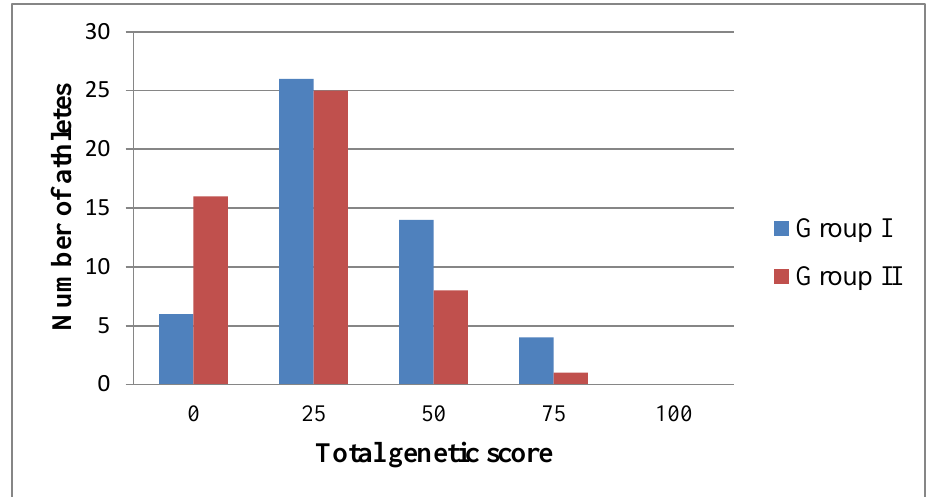
Figure 2. Distribution of the total genetic score established in combatants ( n = 100) for the quality of “ endurance ” , based on the polymorphism of the ACE and BDKRB2 genes.